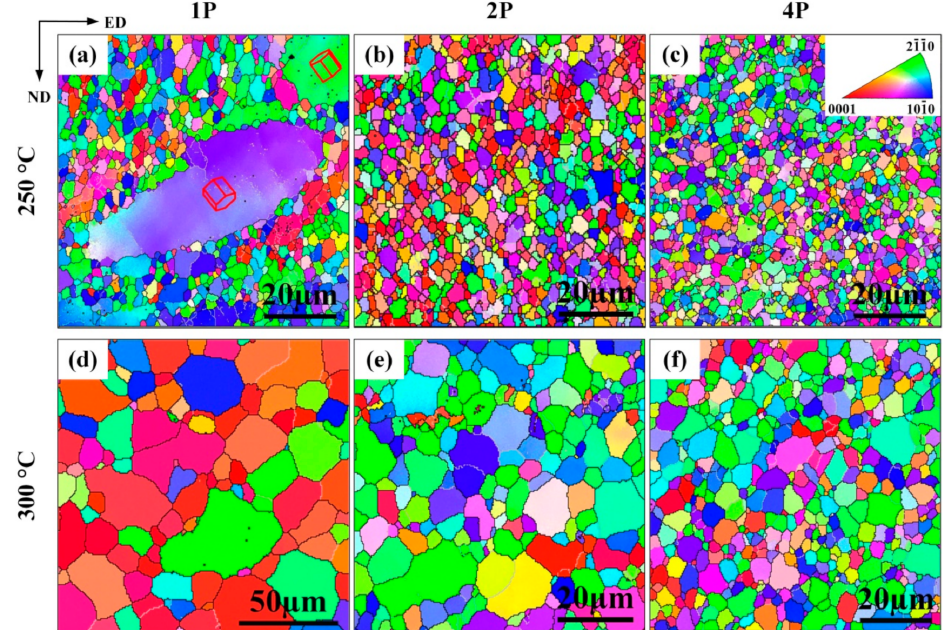
Figure 3. IPF maps of ( a , b , c ) 250 ◦ C-ECAP samples and ( d , e , f ) 300 ◦ C–ECAP samples. ( a , d ) 1 pass, ( b , e ) 2 passes, and ( c , f ) 4